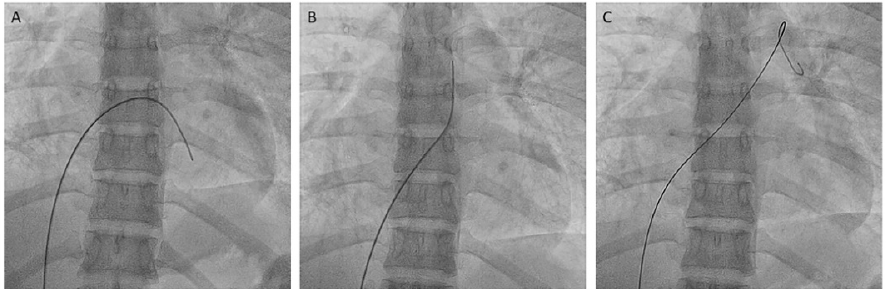
Figure 22. Steps to reach the left pulmonary artery with the MP-A catheter. ( A ): fist step, ( B ): second step, ( C ): third step